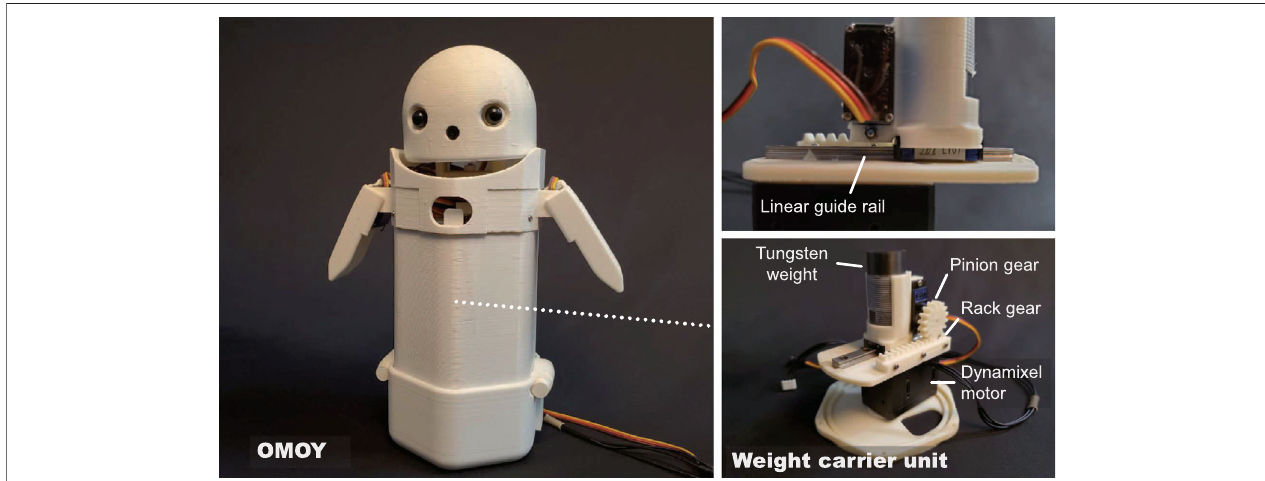
FIGURE2| Robotplatform,namedOMOY,usedinthisstudy.A250 gtungstenweightisattachedtotheweightcarrierunit,whichallowstheweighttomovealong a 2D planar space. We modi fi ed the weight carrier unit from the original version reported in Noguchi and Tanaka (2020): a linear guide rail and a Dynamixel motor were installed.